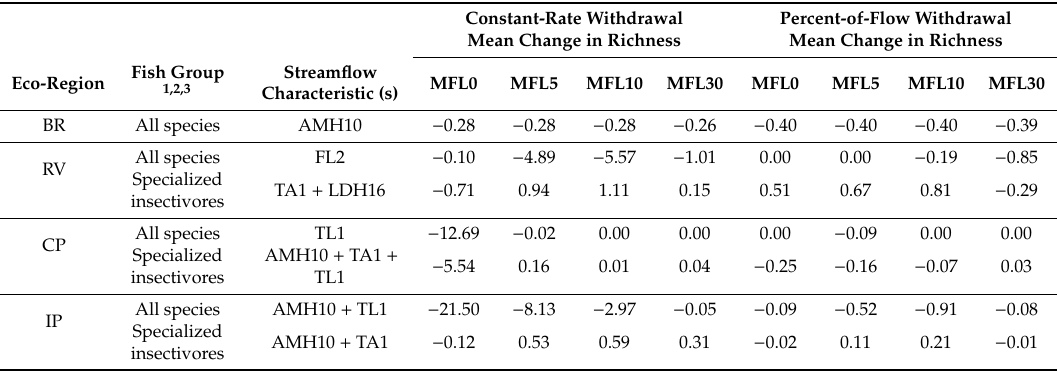
Table 3. Mean change in predicted fish species richness across all stream sites and water-withdrawal scenarios for select fish groups under constant-rate and percent-of-flow